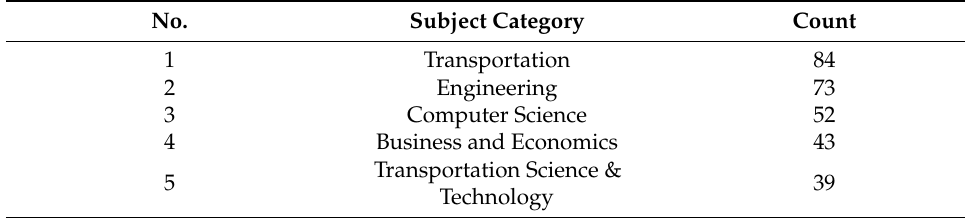
Table 9. Top five categories based on publications.